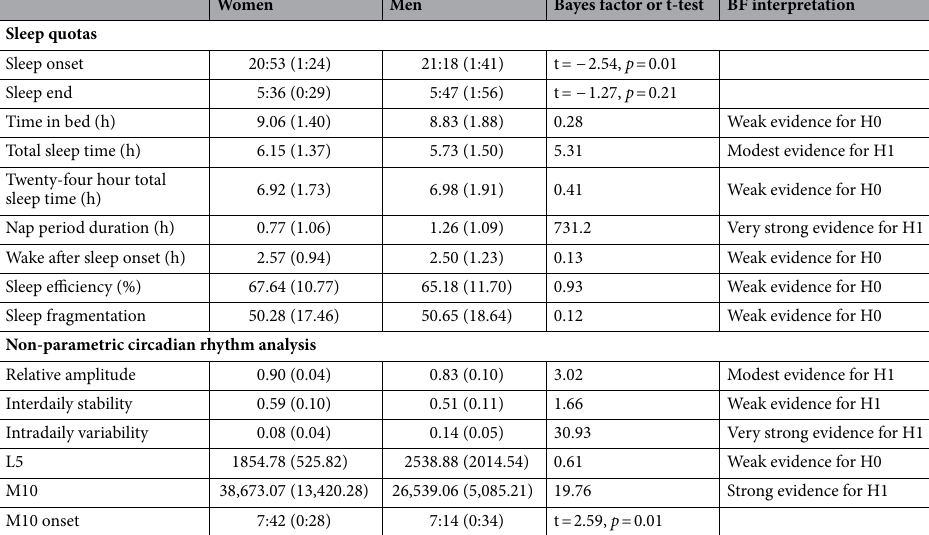
men = 07:14, p = 0.01). There were also slight differences in relative amplitude (BF = 3.02) and interdaily stability (BF = 1.66) between men and women. Linear mixed effects models also revealed significant associations between sleep and gender contingent upon location. With references set as women for gender and village for location for all models, an interac- tion between gender * location was negatively associated with TST (β ± SE = − 0.22 ± 0.09, 95% confidence interval (CI) = [− 0.4, − 0.03]), as well as TTST (β ± SE = − 0.22 ± 0.09, CI = [− 0.4, − 0.04]), indicating a differ - ence in TST and TTST between men and women in the forest but not village locations (see Fig. 1). Addition- ally, sleep efficiency was significantly associated with the gender * location interaction (β ± SE = − 0.24 ± 0.09, CI = [− 0.42, − 0.05]), whereas sleep fragmentation was significantly positively associated with the interaction (β ± SE = 0.20 ± 0.09, CI = [0.02, 0.38]), indicating that men’s sleep was less efficient and more fragmented in the forest as compared to women (see Fig. 2). In the study location, the average time of sunrise in July and August was 05:47, while sunset occurred at 17:58. During these months, average nighttime temperatures ranged from 21 to 25 °C, with an average humidity of 84%. Examining sleep quality in relation to environmental factors, linear mixed effects models demonstrated that sleep efficiency significantly decreased with temperature (β ± SE = − 0.28 ± 0.08, CI = [− 0.43, − 0.12]) and humidity (β ± SE = − 0.28 ± 0.08, CI = [− 0.44, − 0.125]) (see Fig. 2). Rainfall was a positive predictor of TTST (β ± SE = 0.19 ± 0.05, CI = [0.08, 0.30]) (Fig. 2). Humidity, temperature, and age were positive predictors of sleep fragmentation (humidity: β ± SE = 0.33 ± 0.08, CI = [0.16, 0.49]; temperature: β ± SE = 0.19 ± 0.07, CI = [0.04, 0.33]; We used functional linear modelling to demonstrate 24-h circadian activity patterns between men and women overall (see Fig. 3). Women exhibited significantly higher activity levels compared to men throughout most of the day. Figure 3 suggests that both men and women displayed a first peak of high-level activity in the mid- morning; however, men’s activity declined mid-morning and increased again just after noon (though to a lesser extent than their first peak), whereas women’s activity levels plateaued in the mid-morning and declined slightly before increasing again to an even greater activity level in the afternoon. Women also exhibited lower activity levels around ~ 3:00 a.m. and a sharper incline of activity in the morning after waking (~ 6:00 a.m.) compared to men. Functional linear modelling of the forest and village locations (with no differentiation between men The forest location also displayed higher activity levels from ~ 9:00 a.m. until noon. Both locations displayed a similar pattern of a decrease in activity from mid- to late morning (although to a greater extent in the forest), followed by a short rebound of activity in the afternoon before the steady evening decline. While peak activity in the village occurred in the afternoon, the greatest activity in the forest occurred in the morning.